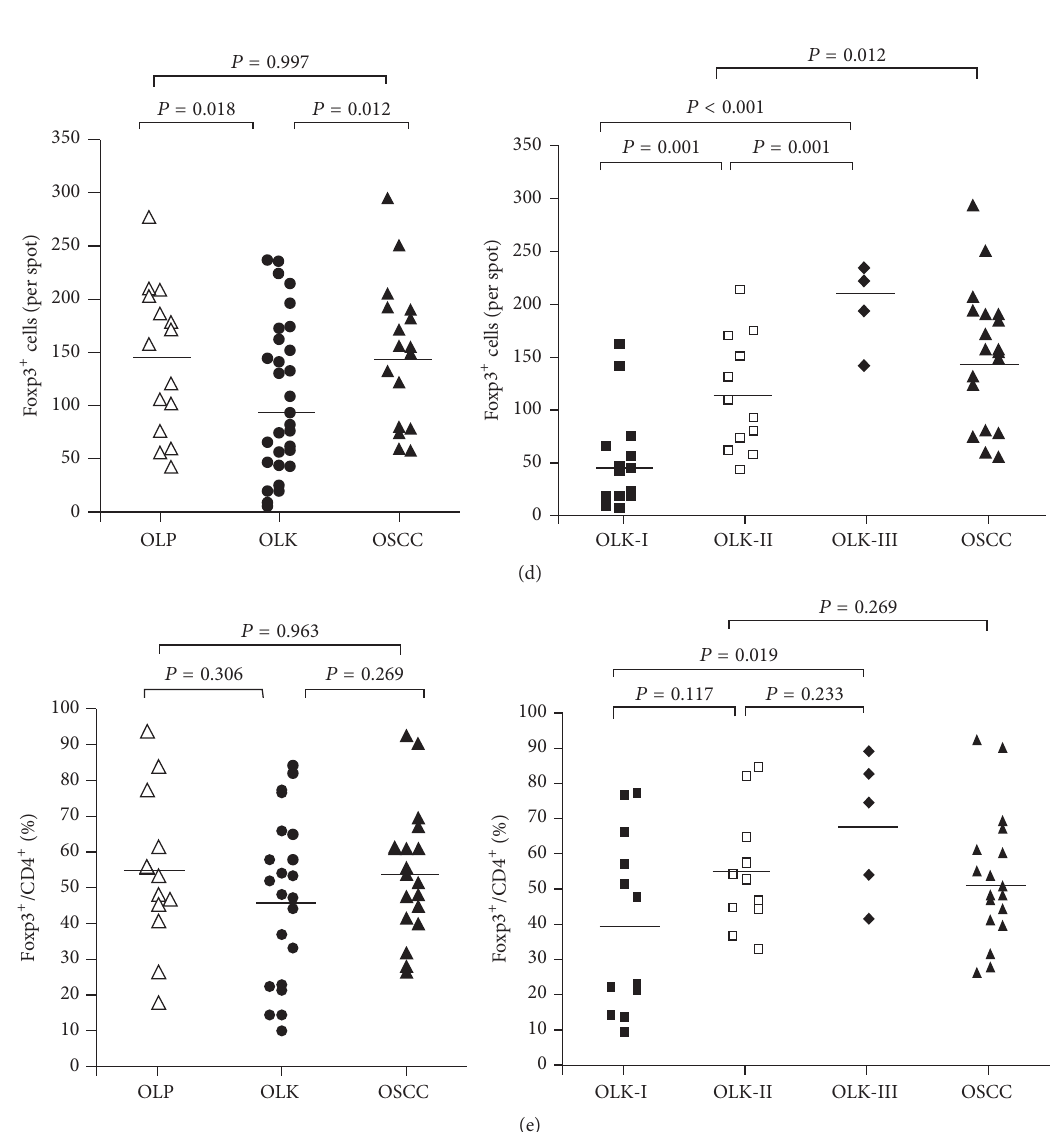
Figure 1: Distribution and frequency of CD4 + T-cells and/or Treg cells in OLP, OLK, and OSCC oral tissue samples. (a) Paired CD4- and (c) Foxp3-immunostained sections. (b) Frequency of CD4 + T-cells. (d) Frequency of Foxp3 + cells. (e) Percentage of Foxp3 + Treg-stained CD4 +